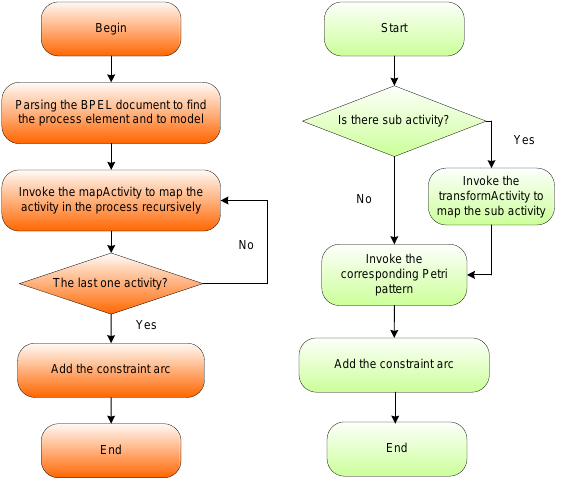
Fig.7. Transforming algorithm